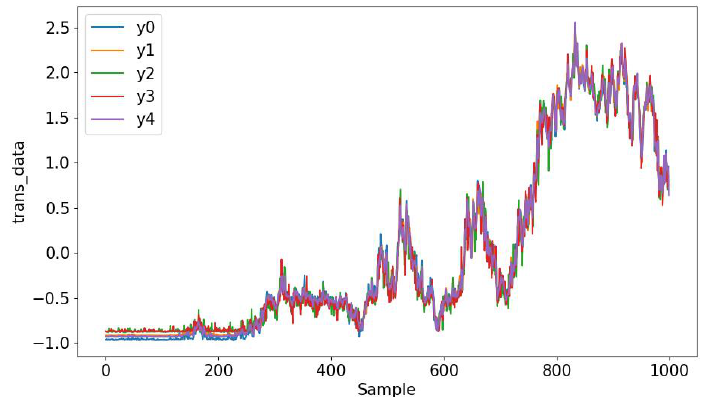
Figure 8. Transformed train data by ACE.